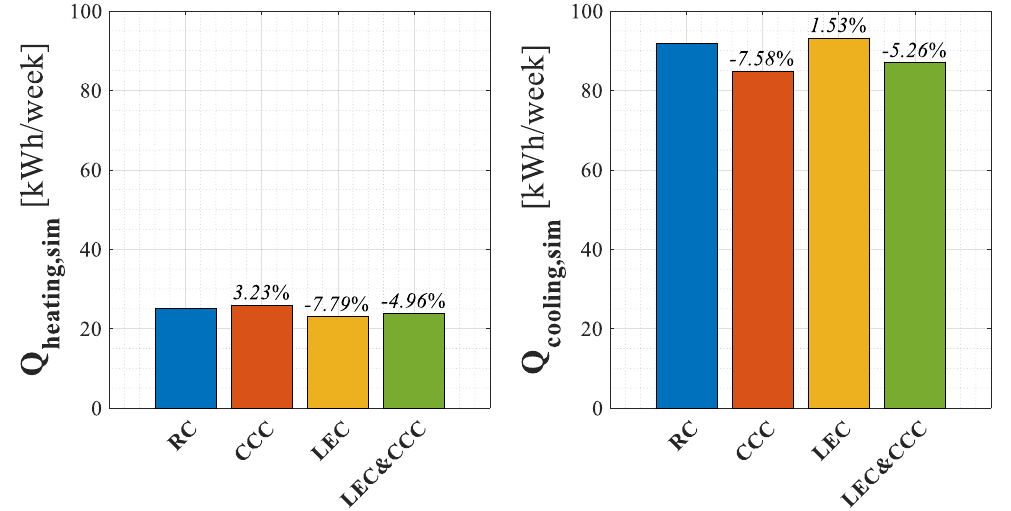
Figure 30. Heating ( left ) and cooling ( right ) demands for RC, CCC, LEC, and LEC&CCC.